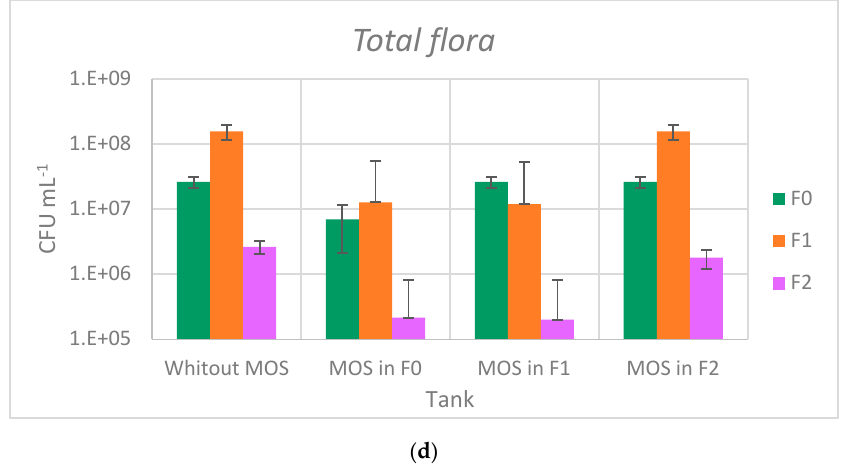
Figure 3. Projection of MO’s effect on the entire treatment plant prototype after MO’s addition in F0, F1, F2; ( a ): abundance of E. coli ; ( b ): abundance of faecal coliform; ( c ): abundance of Vibrio cholera; ( d ): abundance of total flora.